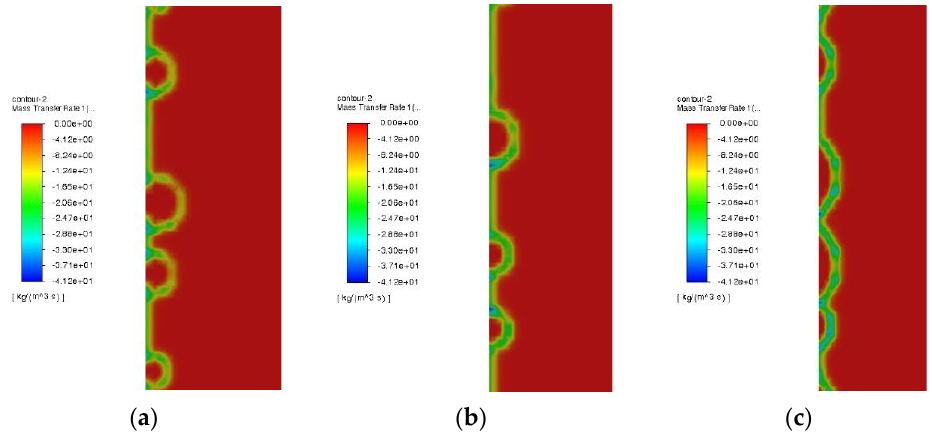
Figure 10. Mass transfer rate at different contact angles: ( a ) θ = 45°; ( b ) θ = 90°; ( c ) θ = 135°.